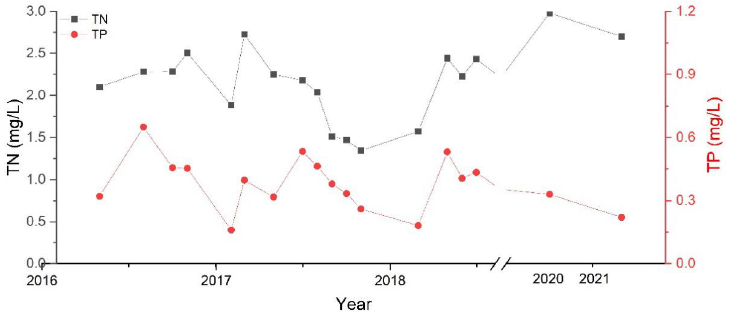
Figure 9. Average TN and TP concentrations in Lake Xingyun from 2016 to 2021. Water quality along the depth gradient in 2017 was analyzed using heatmaps (Figure 10), showing a poor water quality at the top and bottom of the lake. The water quality of Lake Xingyun demonstrated a large seasonal variation. Eutrophication levels were higher in the wet season. The distribution of TP and TN along the depth gradient is illustrated on the heatmap (Figure 11). The highest concentrations of TP and TN were observed at the surface and near the bottom of the lake. Seasonally, the distribution patterns of TP and TN were varied significantly.